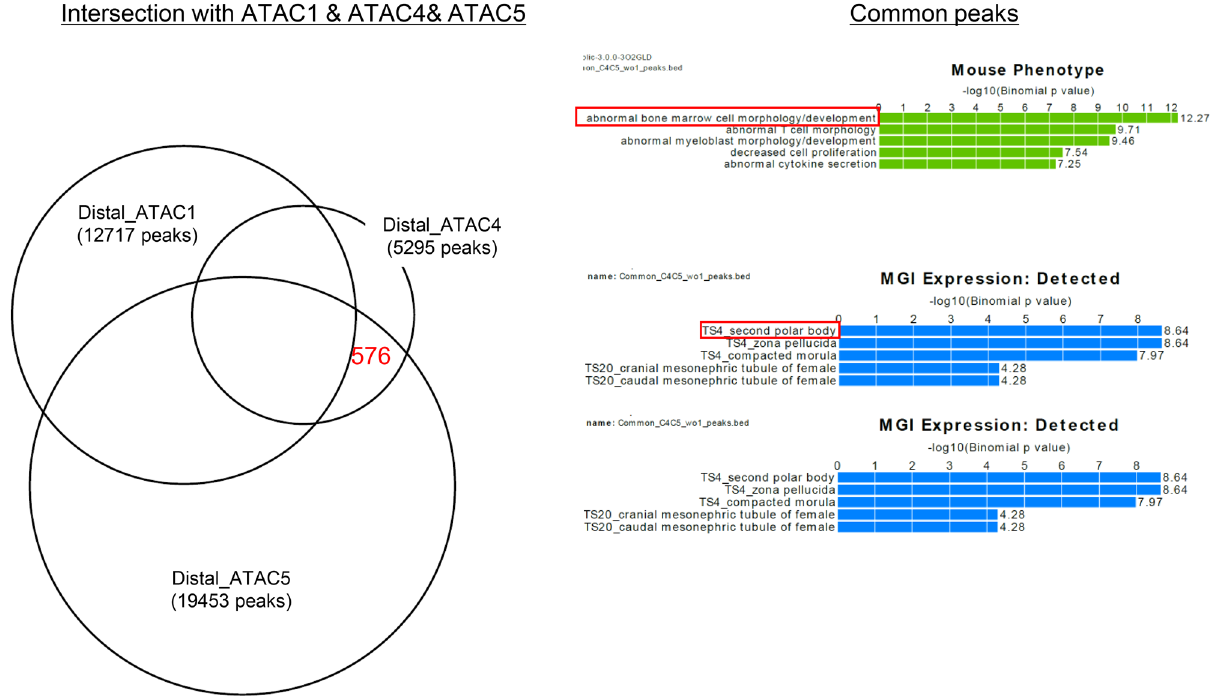
Figure 6. Analysis of open chromatin signals. Open chromatin regions common to clusters 4 and 5 and different from cluster 1 (left) were analyzed by GREAT analysis